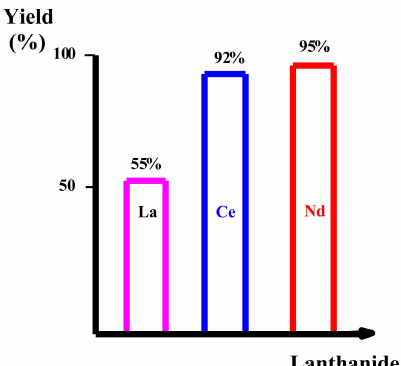
Figure 1. Product yields in Suzuki–Miyaura reaction of 4-bromoanisole with phenylboronic acid catalyzed by 1 – 3